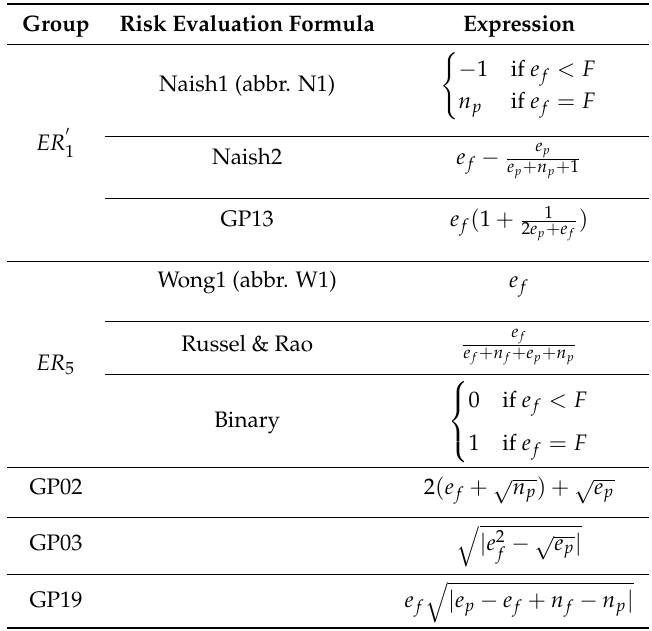
Table 1. Maximal risk evaluation formula